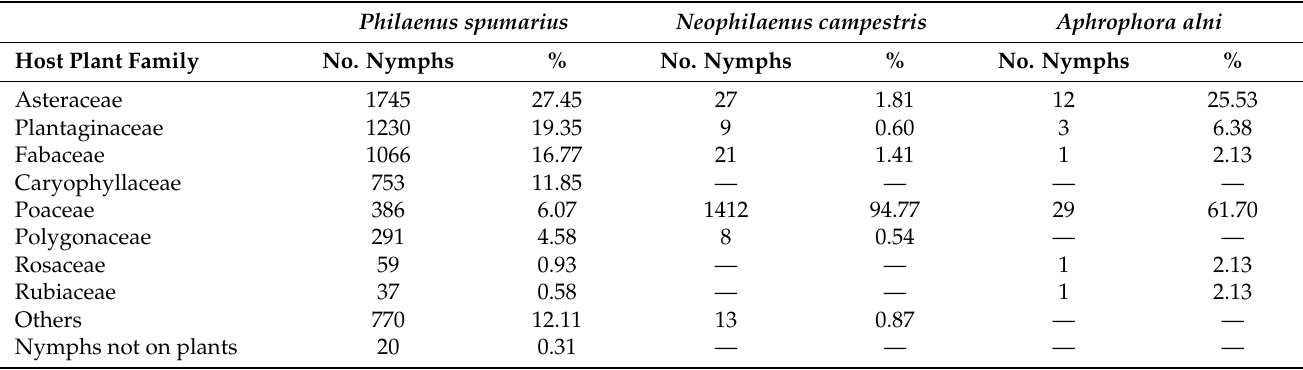
Table 1. Absolute (number) and relative (percentage) distributions of spittlebug nymphs according to plant families on which they were found in an organic vineyard in Asti (northwestern Italy) during the 2016–2017 surveys. Plant families are arranged in descending order of Philaenus spumarius